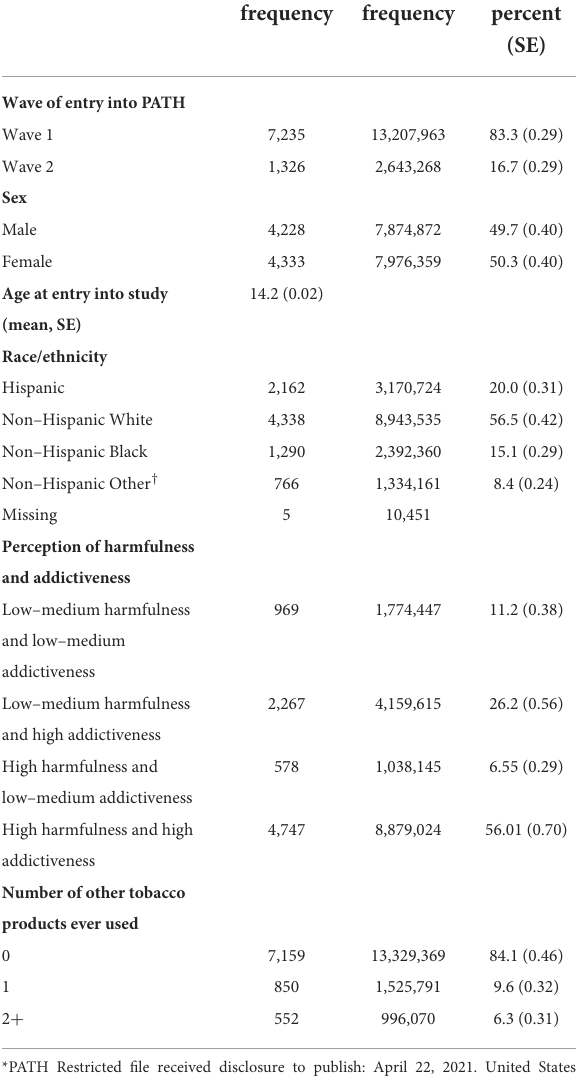
TABLE 3 Sociodemographic characteristics of PATH US youth (aged 12–17) who were never cigar users at their first wave of participation 2013–2016 and who had heard of cigar products ( n = 8,561, N = 15,851,230) * .